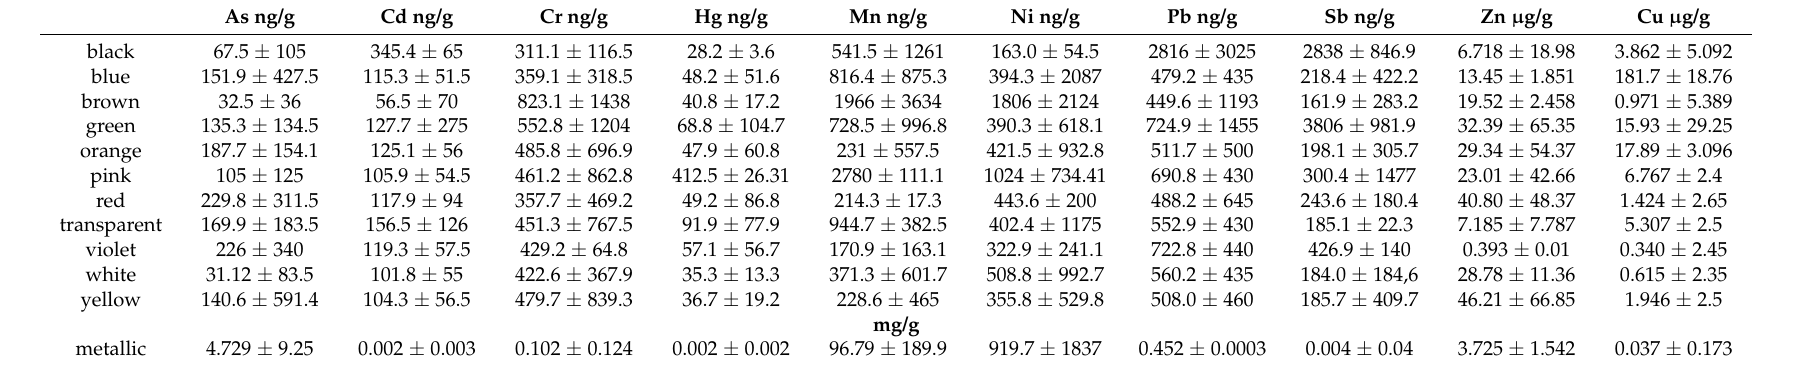
Table 3. Average content of metals and metalloids after mineralization in HNO 3 /H 2 O